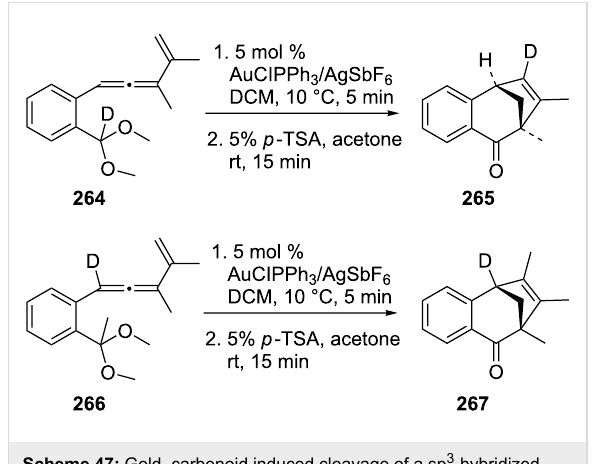
5 Gold-catalyzed tandem